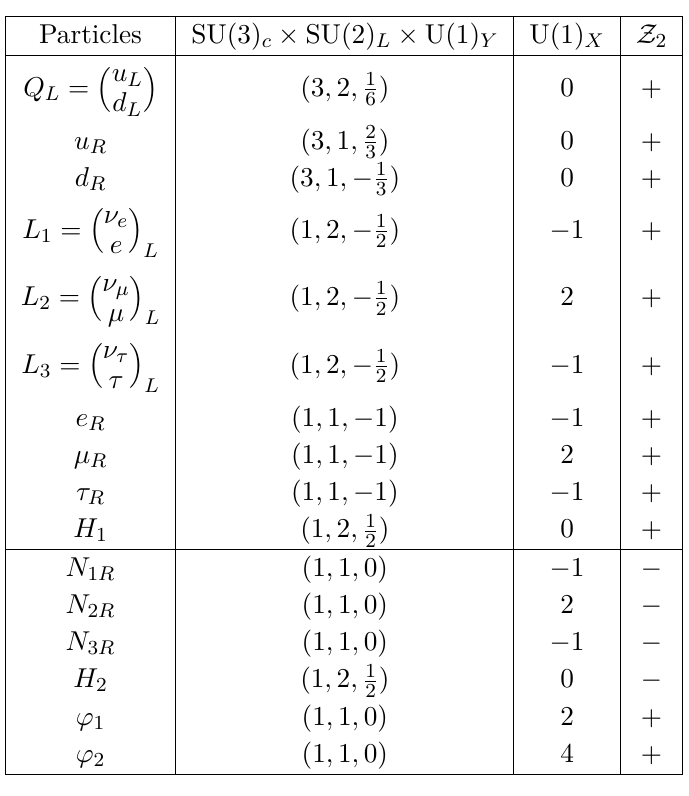
Table 3 . Particle content for Toy Model